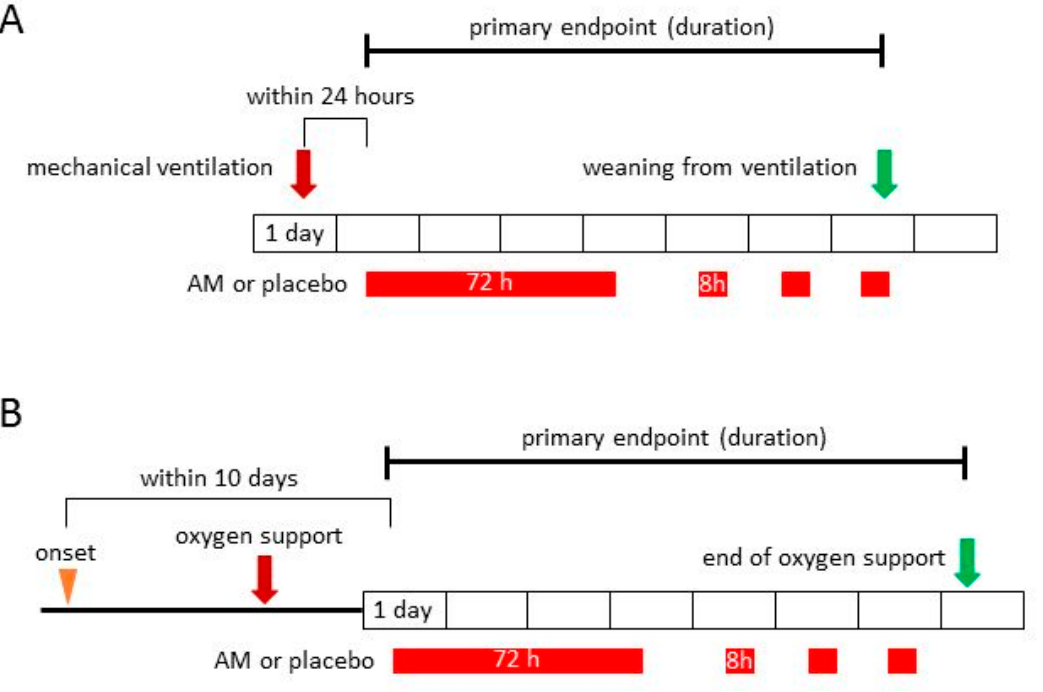
Figure 4. Study designs for severe pneumonia ( A ) and moderate pneumonia ( B ) in patients with COVID-19. AM: adrenomedullin. COVID-19. AM: